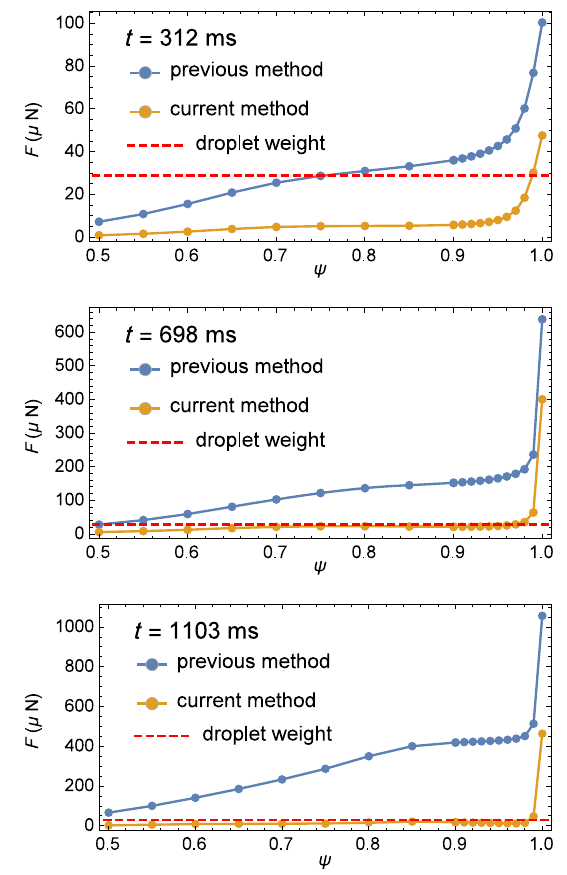
FIG. 16. Evaluation of the integral Eq. (A4) from experimental data with different upper bond ψ R , as defined in Eq. (A5). The red dashed line indicates the weight of